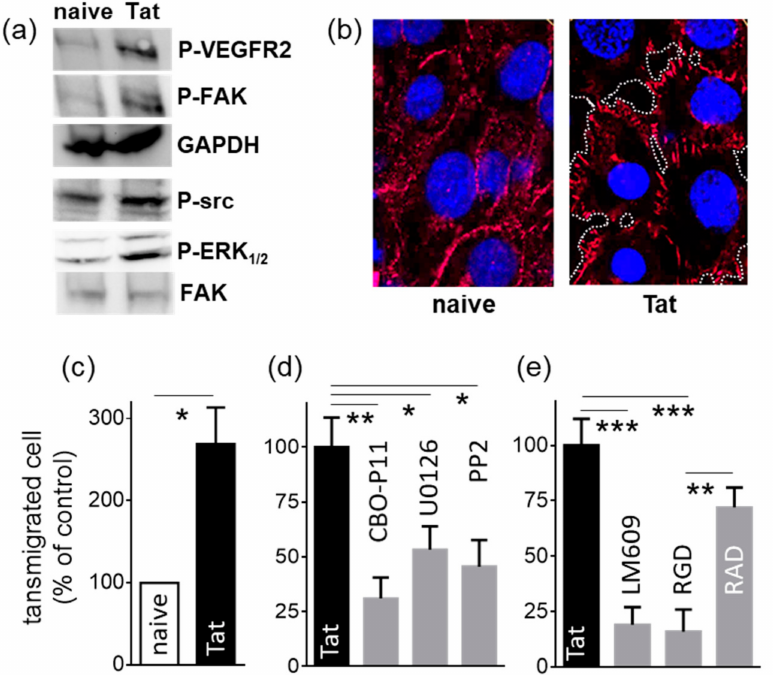
Figure 4. EC activation by Tat-presenting lymphocytes. ( a ) MAEc-VEGFR2 were exposed to naive or Tat-presenting SYN-NCs for 2 h at 37 ◦ C. Then, SYN-NCs were removed by extensive washing, and the EC monolayer was analyzed by WB for the phosphorylation of the indicated proteins. The intensity of each band was normalized with respect to the corresponding control protein. The statistical significance of Tat-dependent activation was then calculated and reported in Table S1. ( b ) Representative microphotographs of EC monolayers exposed to naive or Tat-presenting SYN- NCs, fixed and immunostained for VE-cadherin (red) and nuclei (DAPI, blue). In the right mi- crophotograph, areas uncovered by EC retraction are indicated by white dotted lines. ( c ) Control (naïve) or Tat-presenting SYN-NCs (Tat) were assessed for their capacity to migrate across an EC monolayer in response to CXCL12 (25nM). Data are expressed as % of migrated cells in respect to control ± S.E.M. * p < 0.05, Student t -test. ( d , e ) Tat-presenting SYN-NCs were evaluated for their capacity to migrate in response to CXCL12 (25 nM) across an EC monolayer that was pretreated with the indicated inhibitors. Data are expressed as % of migrated cells in respect to control EC monolayer without any inhibitor (Tat) ± S.E.M. * p < 0.05, ** p < 0.01, *** p < 0.001, one-way